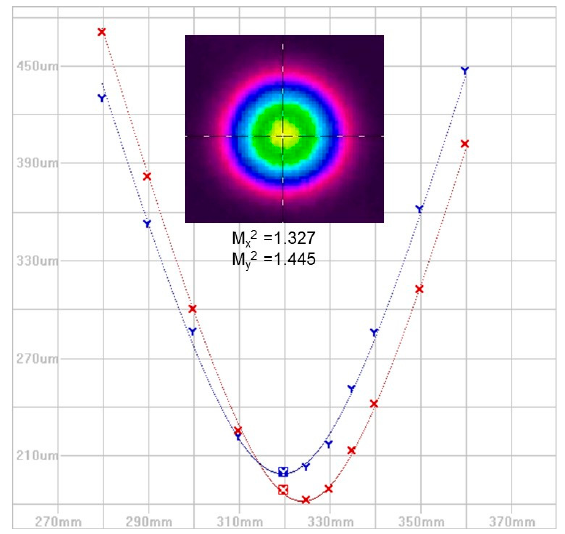
Figure 3. Beam quality of output pulses from regenerative amplifier with the output power of 6.5 W.